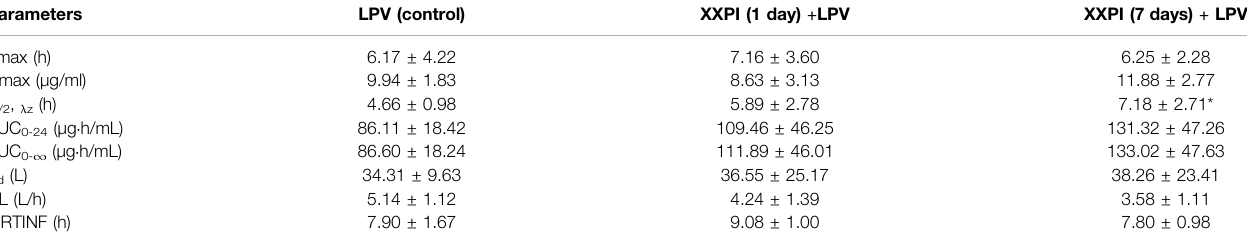
TABLE 1 | Pharmacokinetic parameters of LPV after oral administration of LPV/RTV (42:10.5 mg/kg) in rats that were pretreated with or without XYPI (x ( ) ± SD, n (cid:1) 6). Parameters